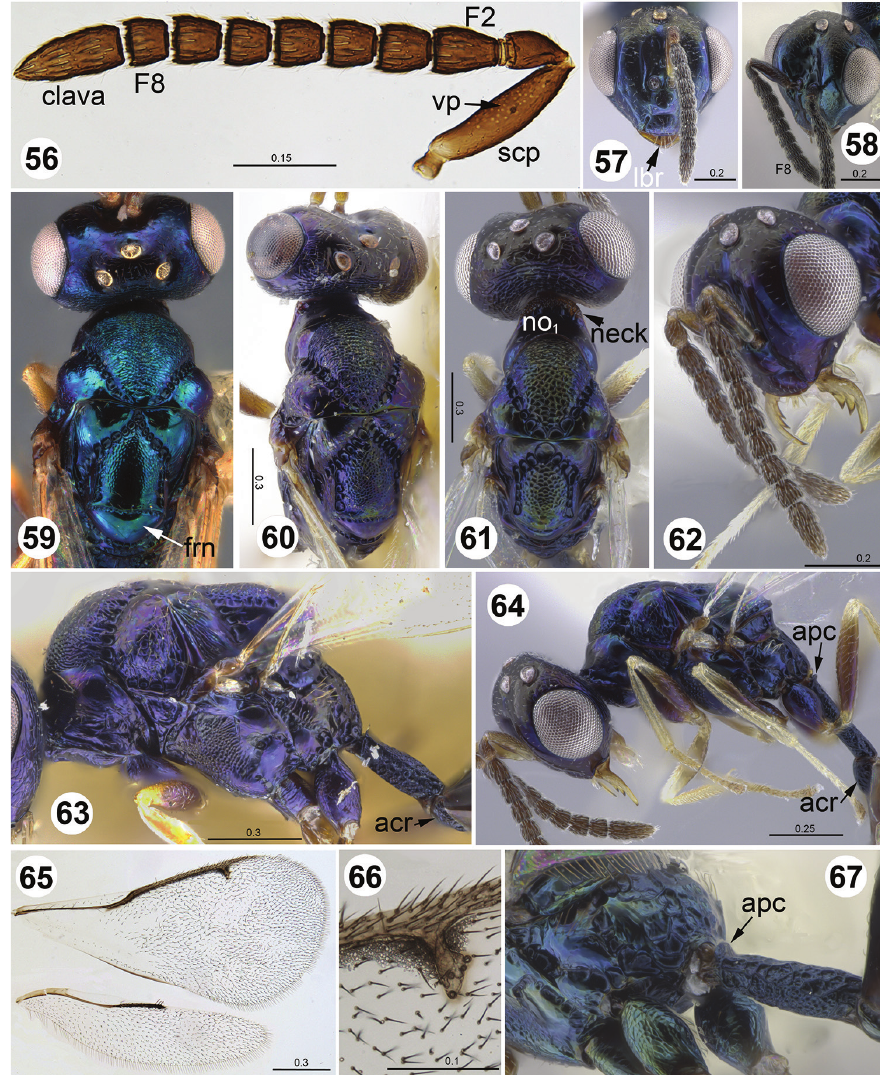
Figs 56–67. Leiosema glabra . Male: 56 antenna, lateral (Tanzania, TZ) 57 head, frontal, (Yemen) 58 head, oblique (TZ). Female holotype 59 head and mesosoma, dorsal; Male: 60 head and mesosoma, dorsal (South Africa) 63 mesosoma, lateral (SA) 65 wings, dorsal (TZ) 66 stigmal vein (TZ) 67 pro- podeum and petiole, oblique (TZ). Leiosema lesiolouna . Holotype male: 61 head and mesosoma, dorsal 62 head, oblique 64 head and mesosoma, lateral.acr = acrosternite; apc = anterior petiolar carina; F = flagellomere; frn = frenum; lbr = labrum; no = pronotum; scp = scape; vp = ventral pores. 1 long; marginal fringe relatively long; submarginal vein with several long setae; mar- ginal vein with minute setae; stigmal vein more than 2.5× as long as broad, slightly angled, slightly narrowed basally and capitate apically (Fig. 66); uncus absent;